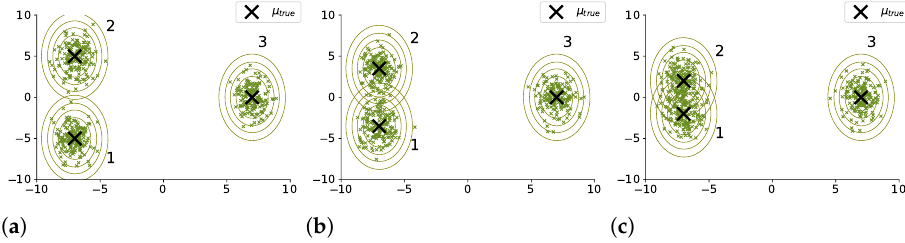
Figure 4. 500 sample points from a Mixture of Gaussians with 3 classes. The true centroid of each Gaussian are depicted by black crosses, and their true covariance matrices are represented by the confidence ellipses of level 0.8, 0.99 and 0.999 around the centre. Each sub-figure corresponds to one of the three different versions of the true parameters. From ( a ) to ( c ): the true µ k of the two left clusters ( µ 1 and µ 2 ) are getting closer while everything else stays